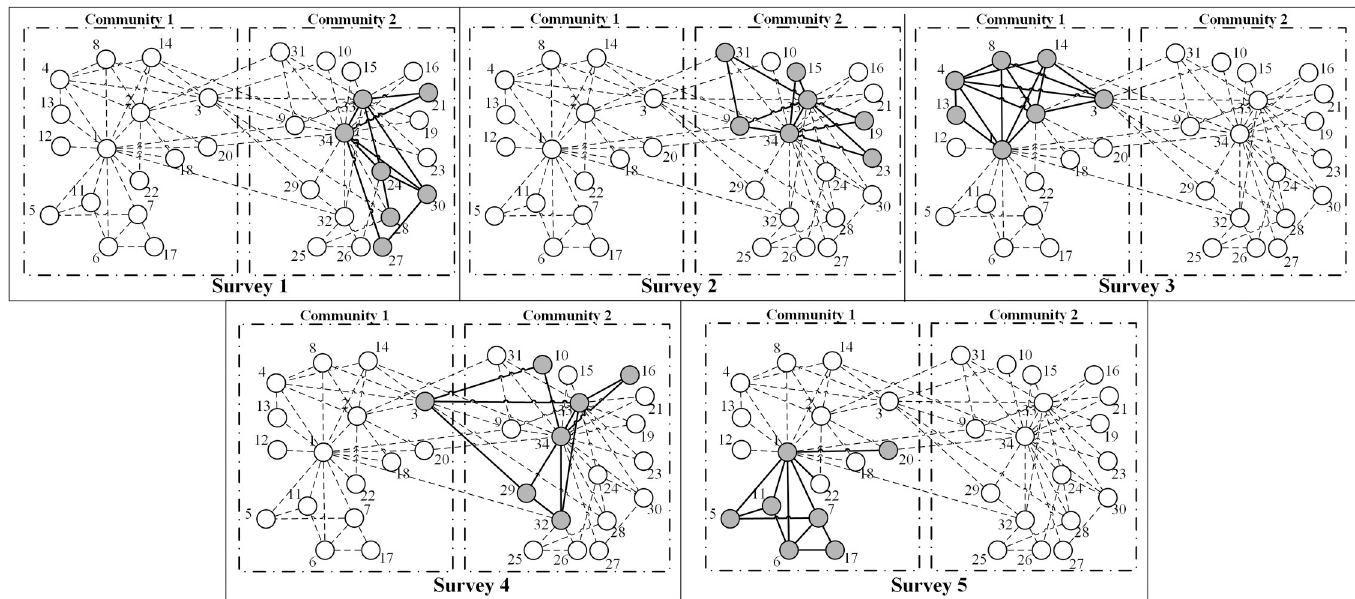
Fig 15. The sampling solution of Zachary’s Karate Club network with k = 0.2 N and m = 5. The club members are divided into two communities. Included nodes are grey, and white nodes represent omitted nodes. The dashed line represents the unobserved ties, while the bold solid line represents the extracted ties.